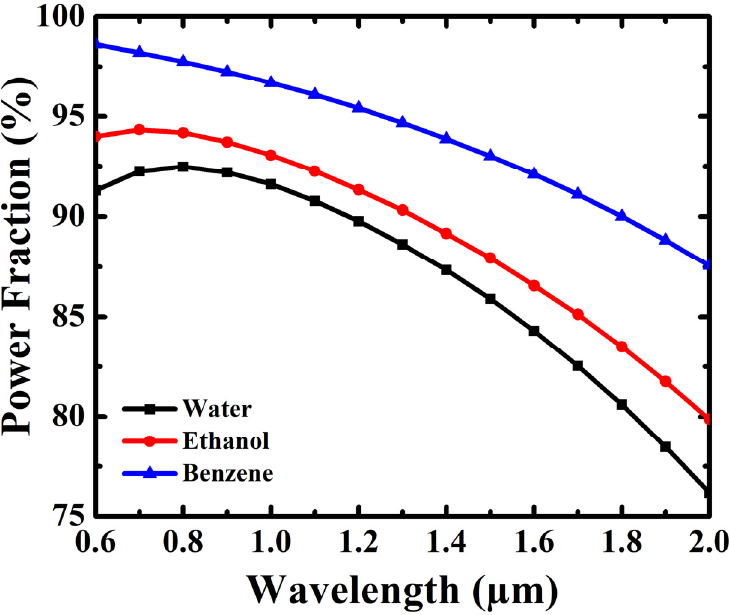
Figure 5. Power fraction of the PCF sensor for water, ethanol and benzene against